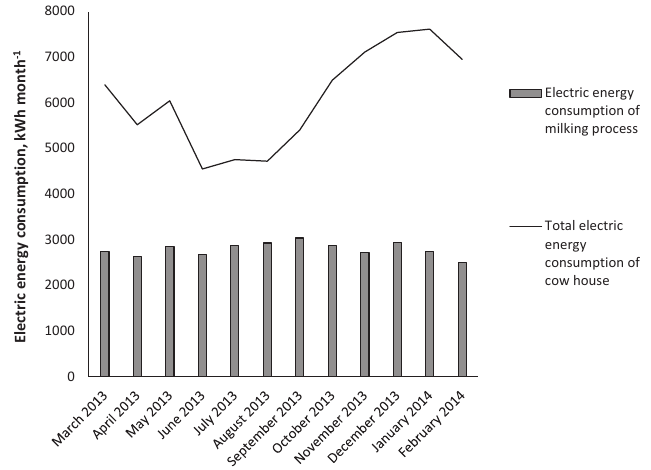
Fig. 1. Monthly electric energy consumption in the cow house and electric energy consumption of the milking process on farm